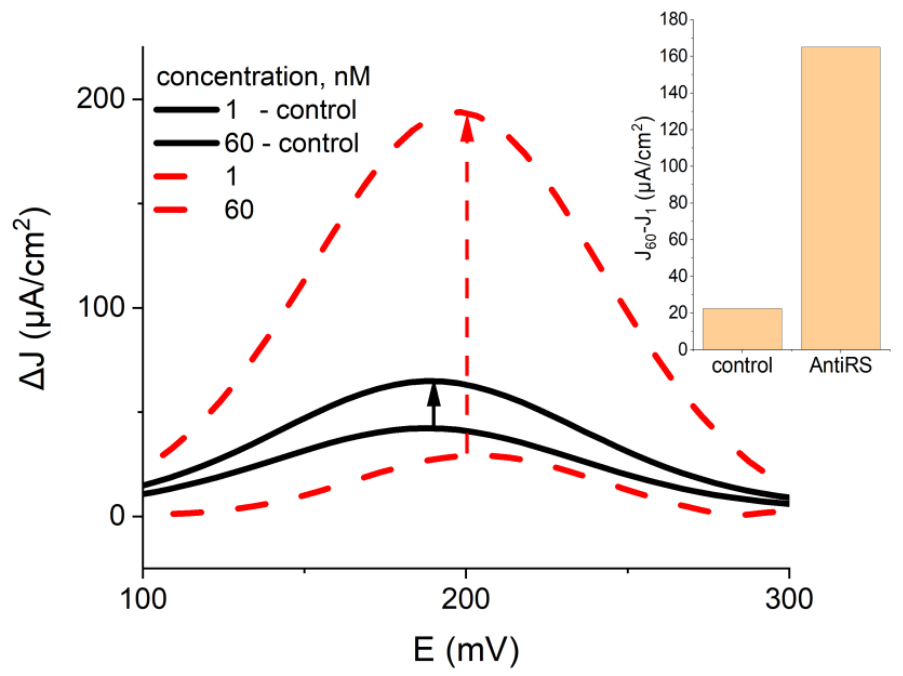
Figure 5. The assessment of specificity of the Au/SAM mix /rS electrode blocked with BSA to serum samples with anti-rS antibodies (red dashed lines) and serum samples without anti-rS antibodies (black lines). Table 2. A summary of different electrochemical sensors for the determination of SARS-CoV-2 virus proteins and this virus-caused infection.